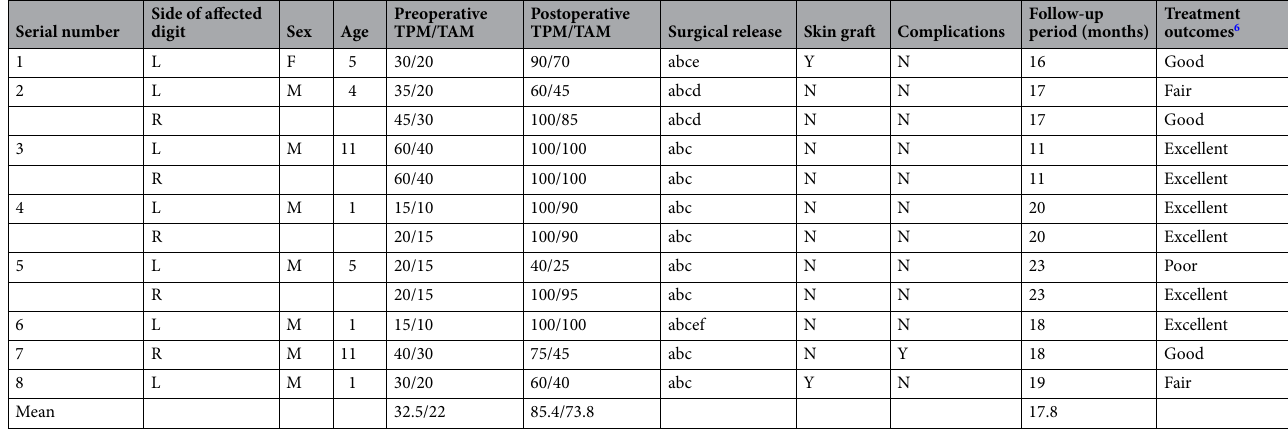
Table 1. Clinical characteristics of the included patients. L, Left; R, Right; F, Female; M, Male; TPM, Total passive motion; TAM, Total active motion; a, Skin release; b, Subcutaneous fascial release; c, Flexor